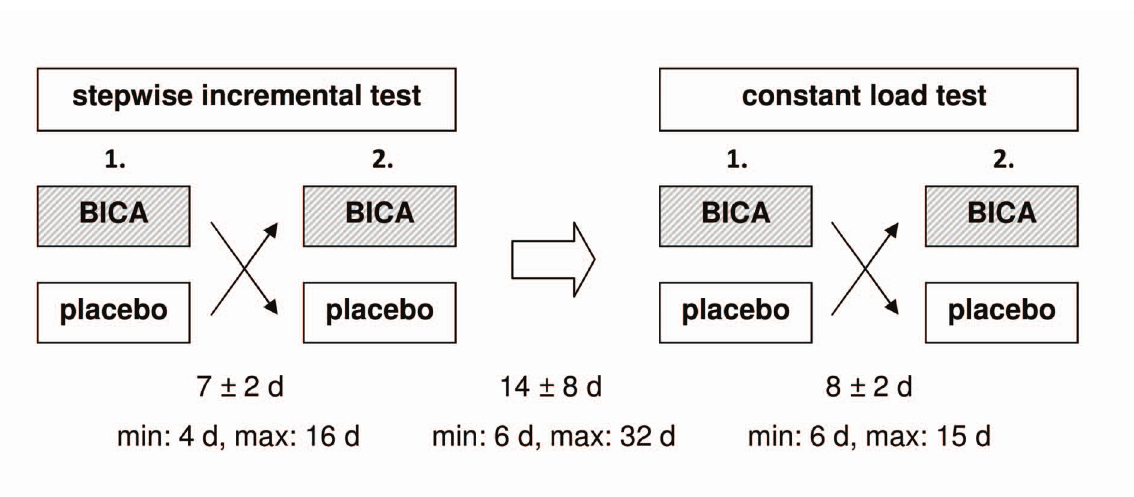
Fig. 1. Schematic representation of the general design. Both stepwise incremental tests and constant load tests were conducted under two conditions: either after oral ingestion of 0.3 g ? kg 2 1 sodium bicarbonate (BICA) or 4 g of sodium chloride (placebo). Time interval between tests is specified in days (d). Data are presented as means ¡ standard deviation respectively, with minimum (min) and maximum (max)